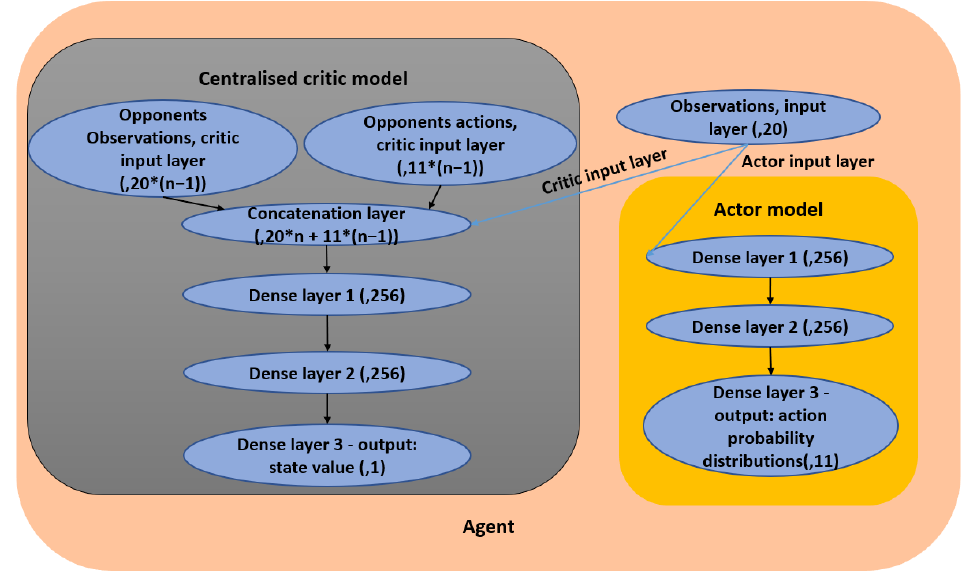
Figure 4. DRL model.